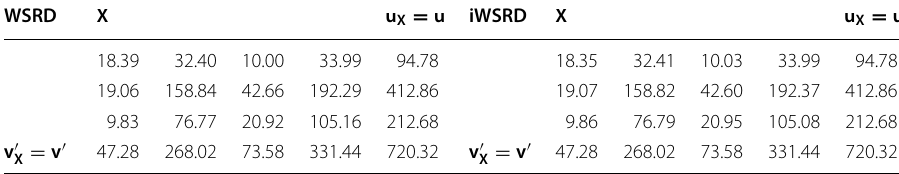
Table 4 The WSRD and iWSRD results for updating the data set from Table 1 WSRD X u X = u iWSRD X u X = u